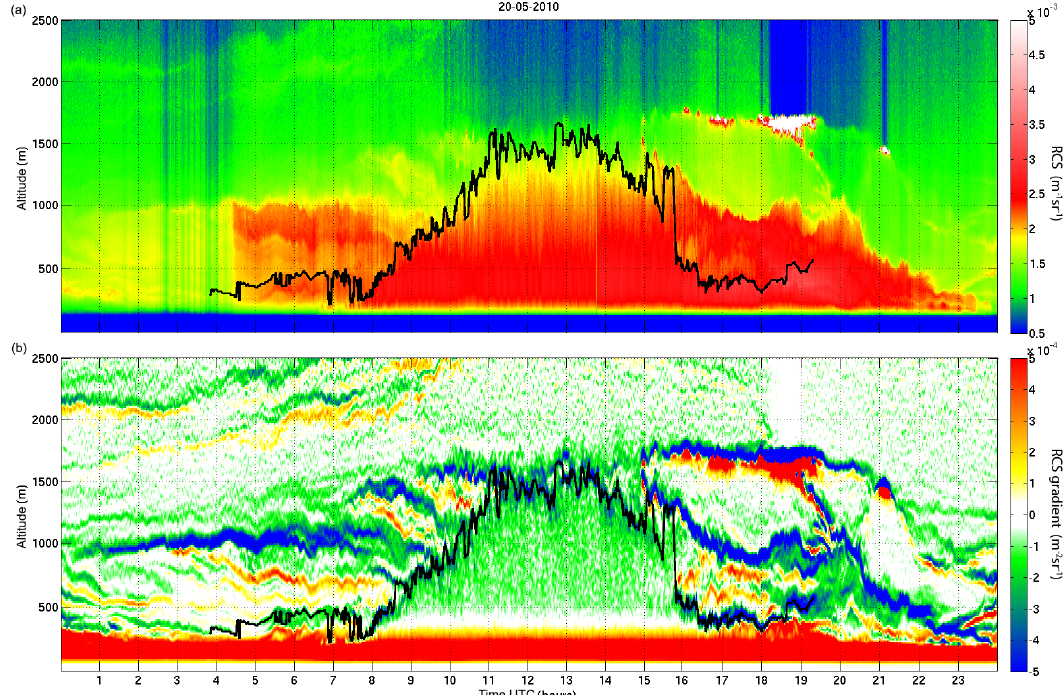
Figure 3. (a) A full diurnal cycle of backscatter lidar profiles from the ALS450 system at Cabauw on 20 May 2010. The data presented are the range-corrected signal, RCS. The black line indicates pathfinder MLH solution. (b) The gradient field calculated from the backscatter lidar data.